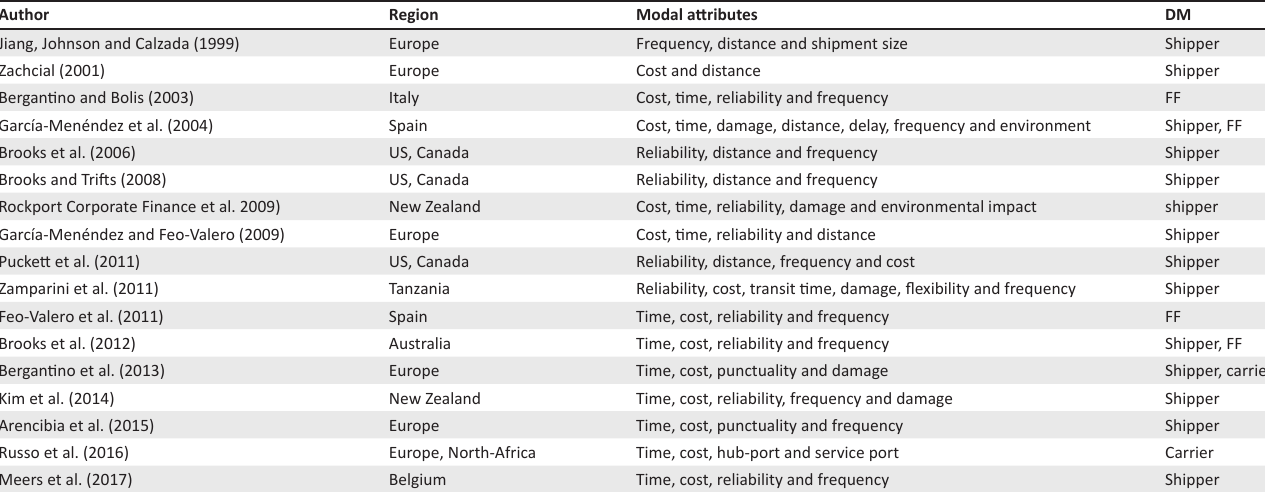
TABLE 1: List of literature on shipper